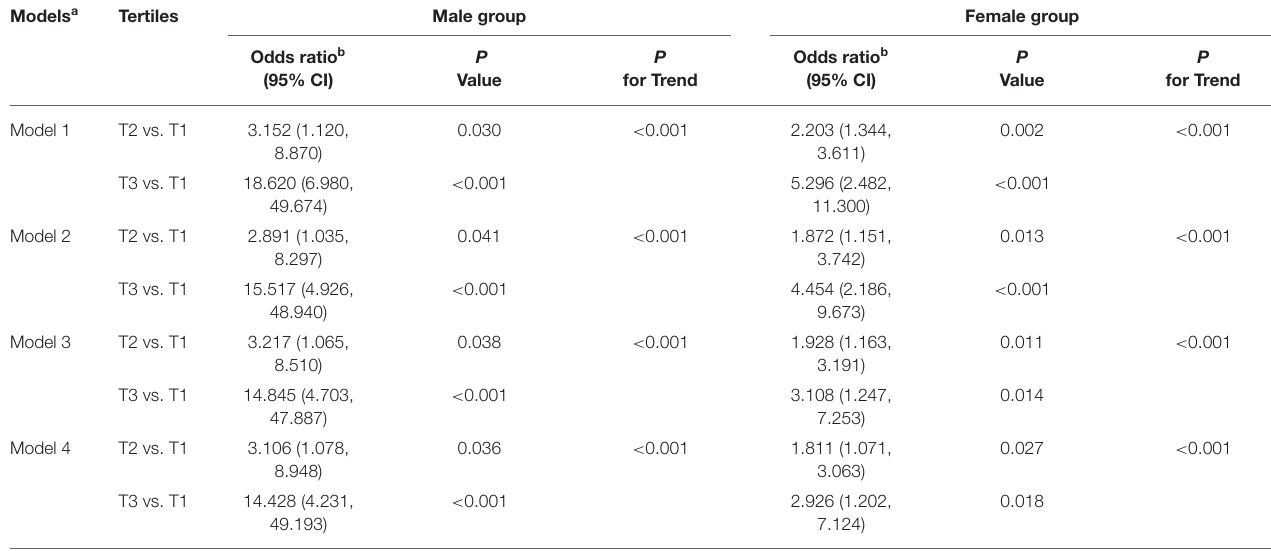
TABLE 2 | Association between the frailty and proteinuria in male and female participants with metabolic syndrome. Models